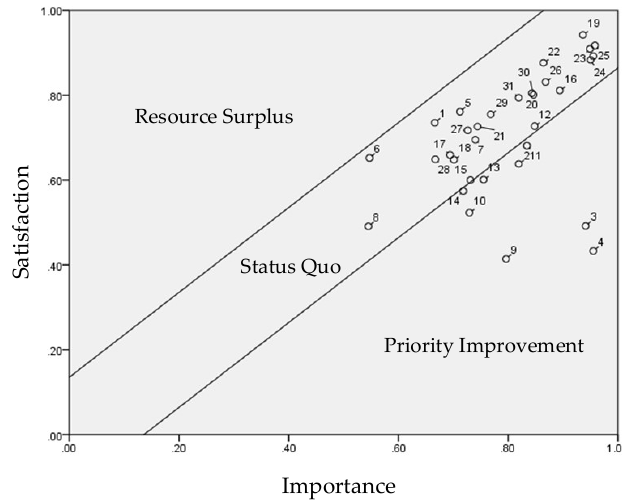
Figure 4. Overall Performance Evaluation Matrix (PEM). Table 5. Importance and Satisfaction Value of Elements Based on